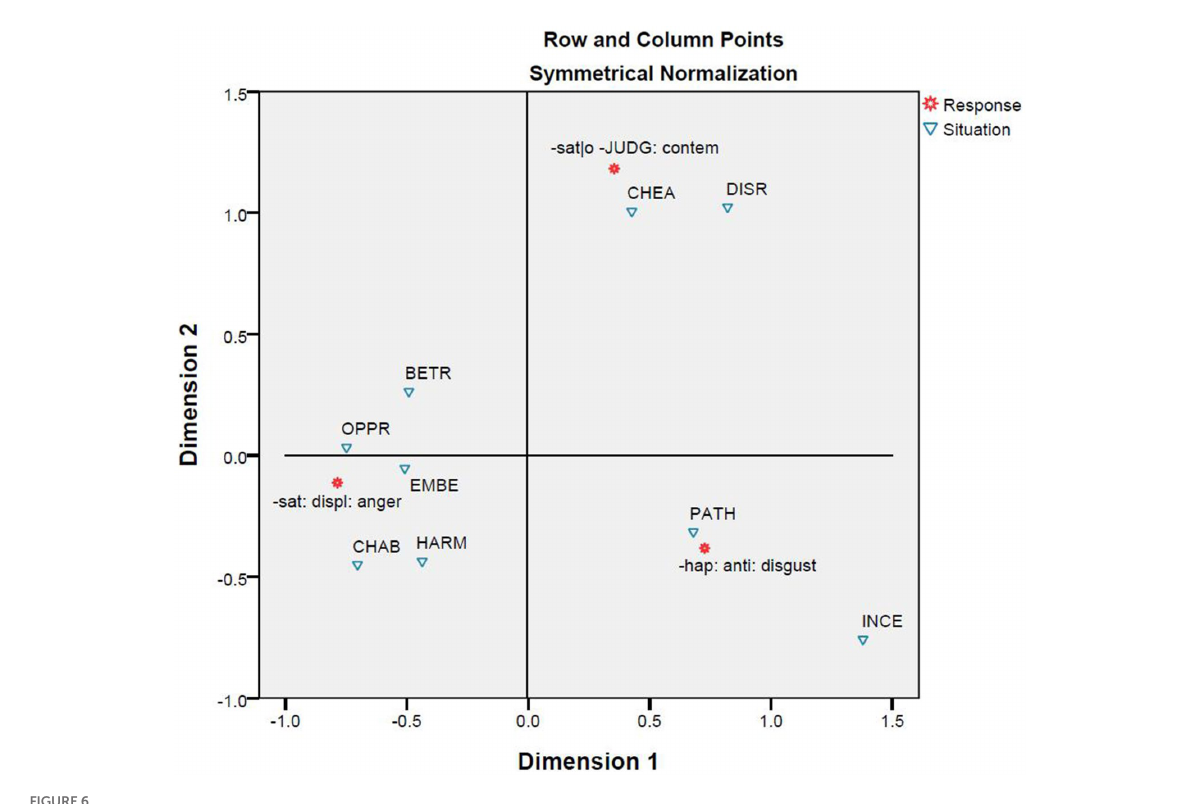
FIGURE 6 Correspondence analysis between situation and